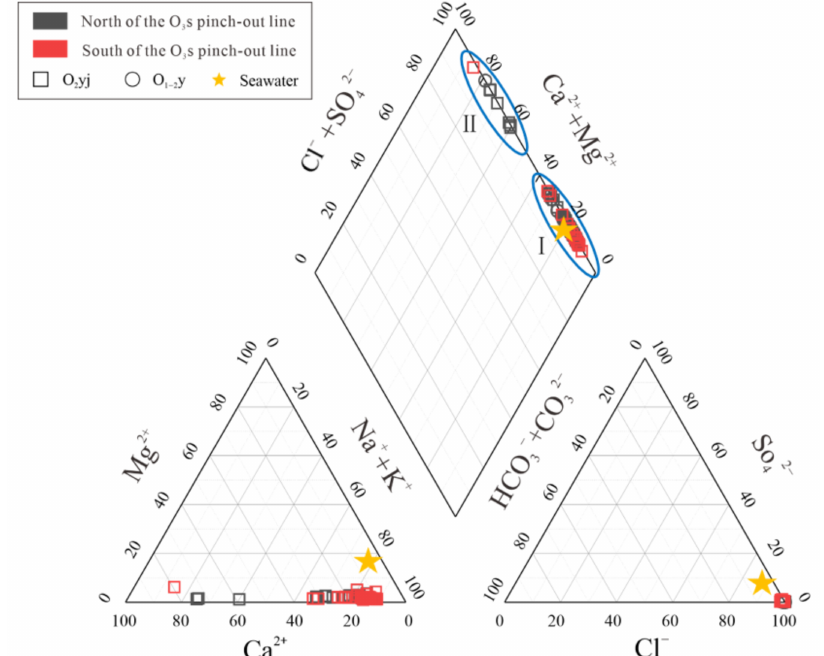
Figure 5. Piper diagram of Ordovician formation water in the Halahatang depression. I: Cl-Na type and Cl-Na · Ca type; II: Cl-Ca · Na type; and Cl-Ca type. These two types of water are distributed in both North Region and South Region, indicating that the formation water experienced strong water-rock interactions in the Halahatang